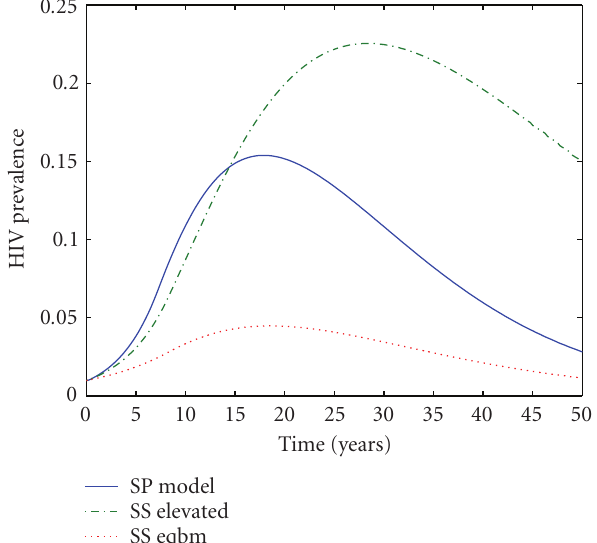
Figure 2.2 . Single stage (SS) and staged progression (SP) HIV prevalence projections for a high prevalence setting, C 0 =